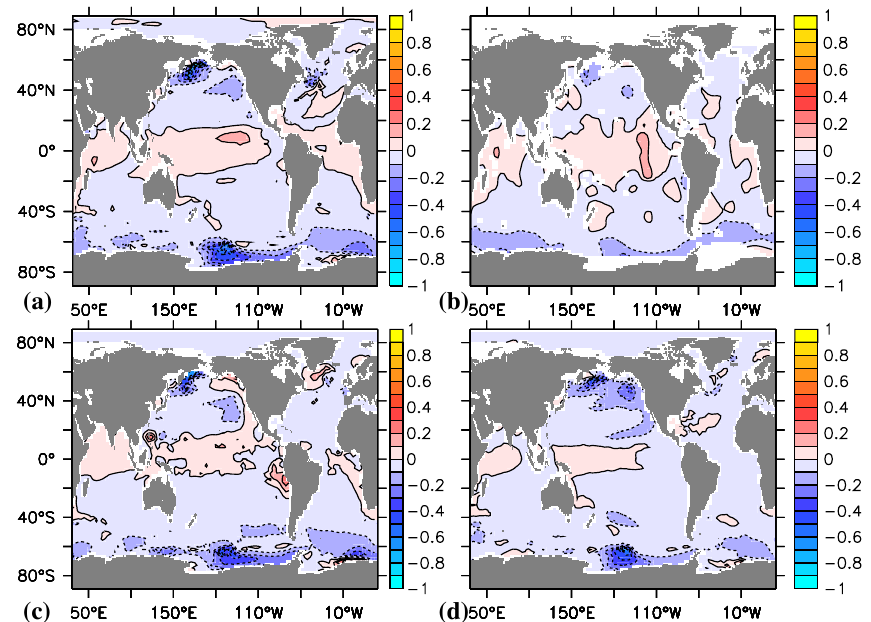
Fig. 4. Simulated linear trend of dissolved oxygen at 300dbar for the period 1960 to 2010 (a) for the standard configuration of Duteil and Oschlies (2011) with a diapycnal background diffusivity of k bg =0.15cm 2 s − 1 and constant (Redfield) C:N stoichiometry, (c) for a much reduced background diffusivity of k bg =0.01cm 2 s − 1 and constant C:N stoichiometry, and (d) for increased background diffusivity of k bg =0.3cm 2 s − 1 . (b) shows the trend estimated for the model results subsampled according to the dates and locations of the read DO measurements and using the same routine that was applied to the in situ data in Fig. 2. Units are µmolkg − 1 yr − 1 .